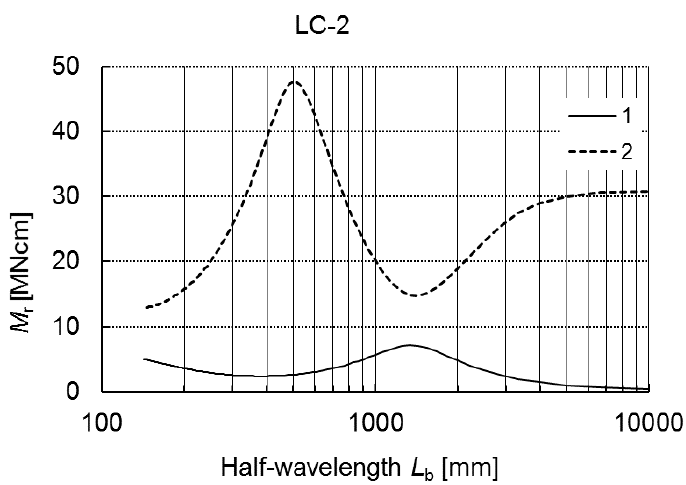
Figure 6. Buckling moments M r as a function of the buckling half-wavelength L b for LC-2. Curve 1 corresponds to the lowest critical values of the bending moment, i.e., the primary buckling moments, whereas curve 2 corresponds to the secondary buckling moments. Curve 1 decreases in the range 100 ≤ L b ≤ 400 mm, and then it increases up to the maximal value at L b = 1500 mm. For higher lengths L b , the critical moment decreases monotonously. On the other hand, curve 2 grows monotonously for 100 ≤ L b ≤ 500 mm to attain its maximal value at L b = 500 mm. At 500 ≤ L b ≤ 1500 mm, it decreases sharply to grow next in the range 1500 ≤ L b ≤ 4000 mm, and then the critical values remain constant for L b ≥ 4000 mm in point of fact.